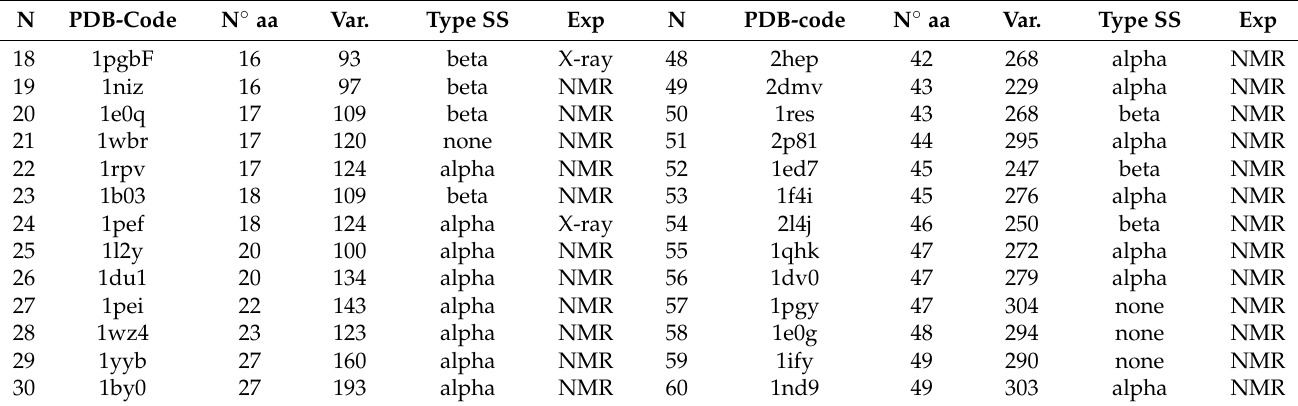
labeled with a letter W, representing the winning method for the group. For the TM-score metric, we present in Figures 6–8 the mean of the five best scores for each algorithm and the mean of the corresponding scores in GDT-TS and RMSD. For each algorithm, we performed a W-count to determine the most frequent